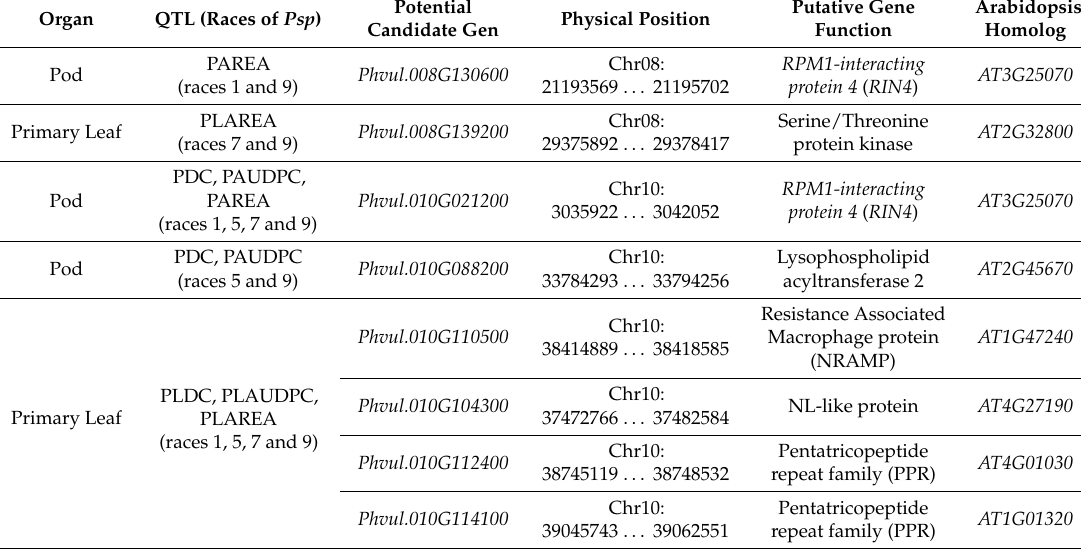
Table 7. Potential candidate genes within each QTL region, physical position, putative predicted gene function and Arabidopsis homologs (Phytozome, release v2.1 of the Phaseolus vulgaris